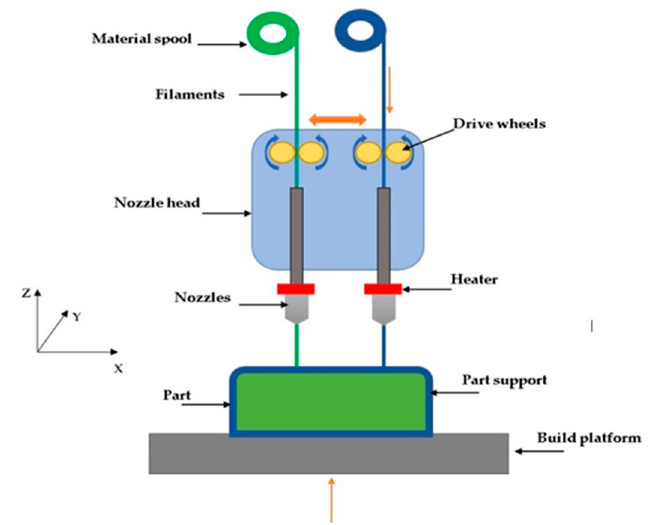
Figure 1. Schematic of FDM components.